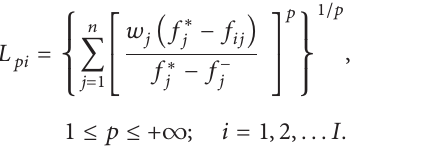
Figure 2: Triangular fuzzy number